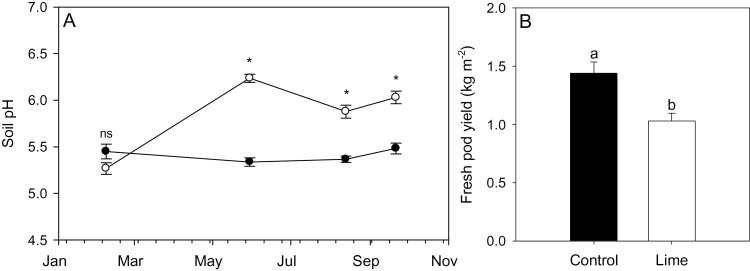
Soil pH of limed (open circles) and unlimed controls (filled circles) during the Vicia faba cropping cycle (A). Total fresh pod yield of limed and unlimed (control) V. faba recorded 21 weeks after drilling in the field trial (B). Data are means ±SE of four treatment plots. Asterisks (A) and different letters above bars (B) indicate a significant difference (P<0.05) as determined by a Student t-test.